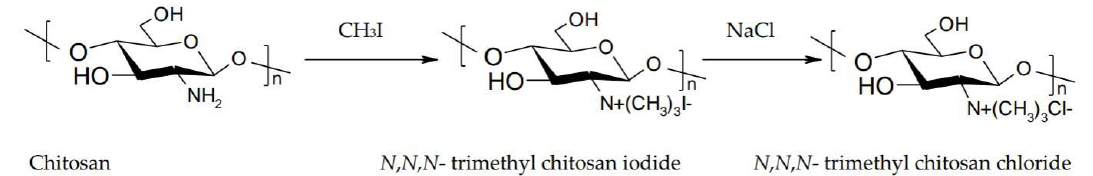
Figure 10. Schematic illustration of N -trimethyl chitosan synthesis.